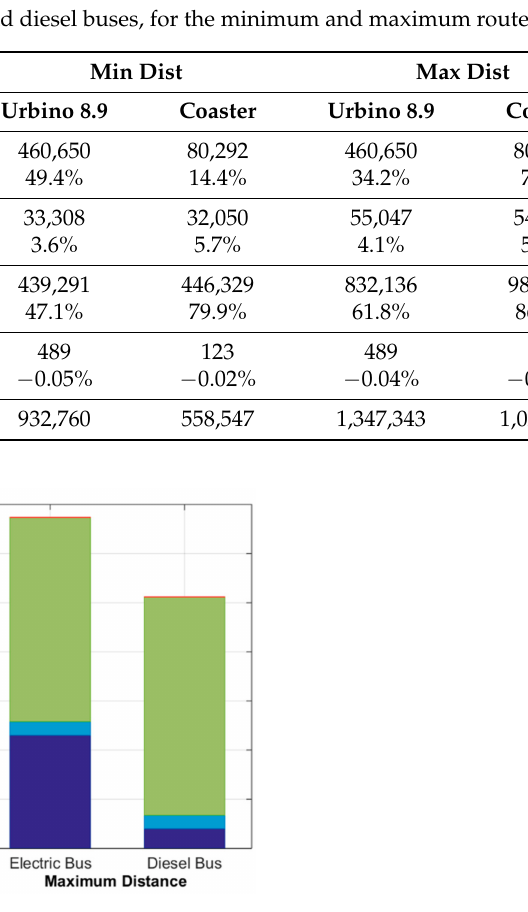
Figure 3. LCCs of diesel and electric buses, with breakdown of their ACs, MCs, OCs and DCs. For both scenarios, the LCC of EB is comparatively higher than the LCC of DB. For buses on the minimum distance route, the LCCs of EB and DB are USD$932,760 and USD$558,547, respectively, showing that EB is 67% more expensive than DB. For buses on the maximum distance route, the difference is less, with EB only 31.6% more expensive